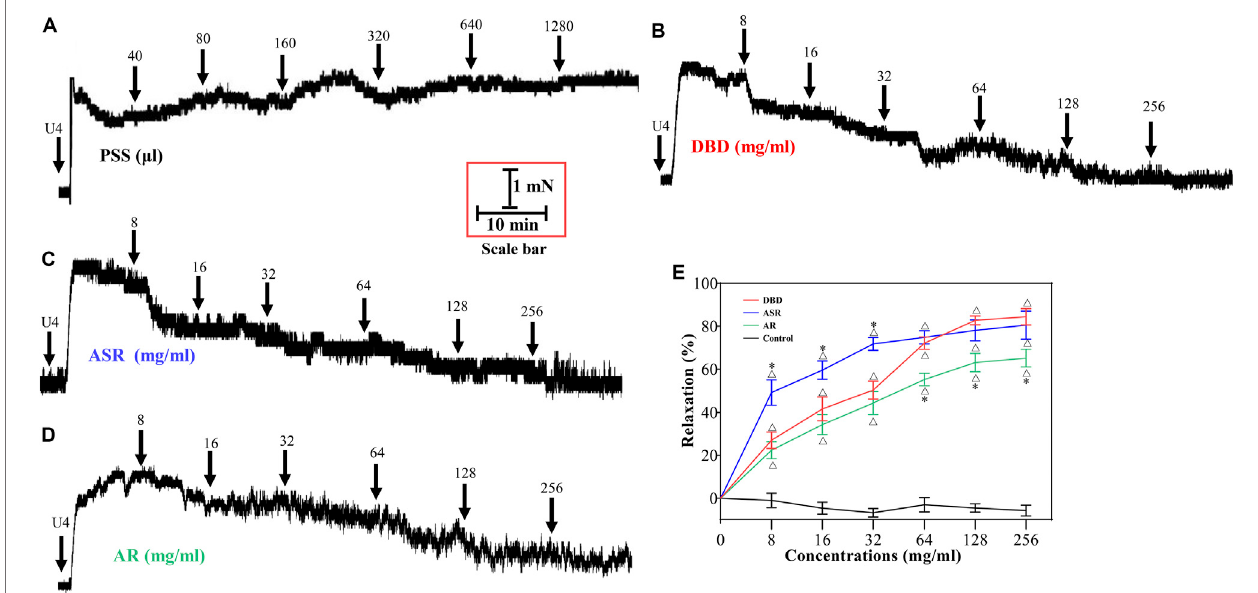
FIGURE7| EffectofDBD,ASR,andARonvasculartensionofMCAunder1 μ MU46619precontractionconditions.Diagramsoftheeffectofcumulativeadditionof PSS (A) , DBD (B) , ASR (C) , and AR (D) on U46619 preconstricted MCA of rats. (E) Comparison of vasodilators by DBD, ARS, and AR on MCA of rats. Data were expressed as the mean ± S.E.M. (n (cid:2) 5). △ p < 0.05 vs the control group; * p < 0.05 vs the DBD group. DBD, Danggui Buxue decoction. ASR, Angelicae Sinensis Radix. AR, Astragali Radix. MCA, middle cerebral artery.